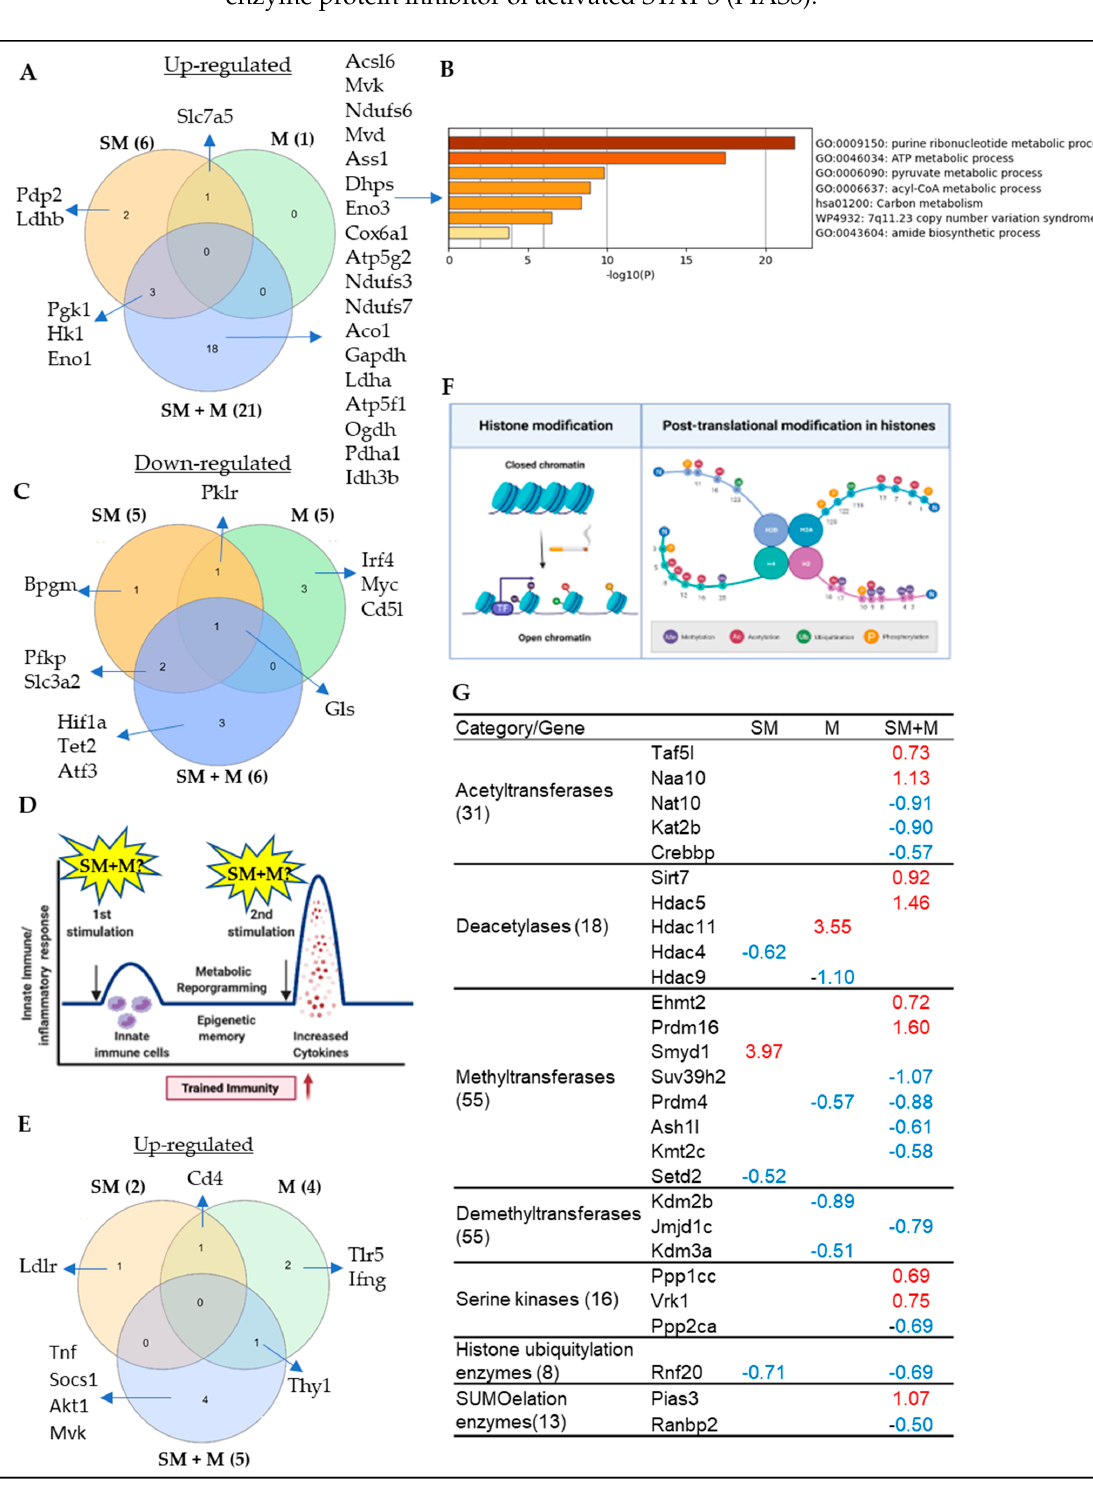
Figure 5. ( A ) The knowledge based analysis indicated that cigarette smoke plus morphine (SM + M), morphine (M), and cigarette smoke (SM) significantly upregulated the transcripts of 21, 1, and 6 genes out of 266 immunometabolism genes. ( B ) The metascape pathway analysis of the SM + M upregulated transcripts of immunometabolism genes. ( C ) SM + M, M, and SM significantly downregulated the transcripts of 6, 5, and 5 out of 266 immunometabolism genes. ( D ) The